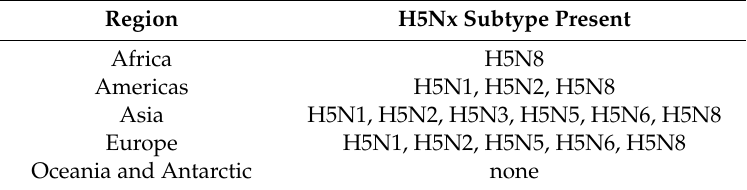
Table 1. Regional distribution of clade 2.3.4.4 highly pathogenic avian influenza (HPAI) H5Nx subtypes from 2008 to